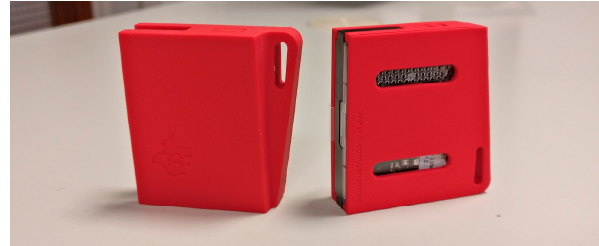
Figure 7. SensorTag from Texas Instrument used in the ePhysio prototype as wearable devices.